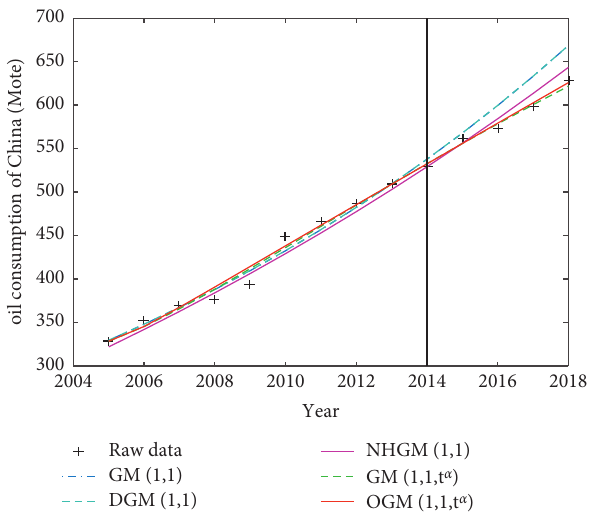
Figure 5: Curves of raw data and simulated values in oil consumption of China from 2004 to